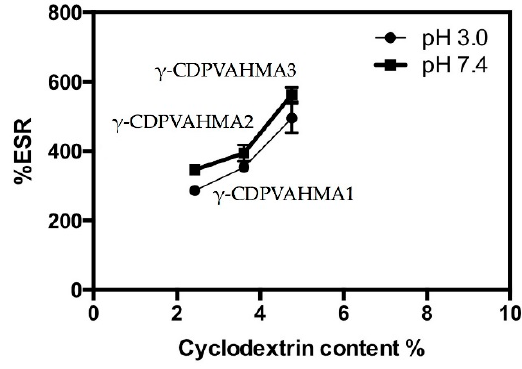
Figure 6. %ESR of γ -CDPVAHMA1, γ -CDPVAHMA2, and γ -CDPVAHMA3 at pH 3.0 and 7.4 with respect to time.